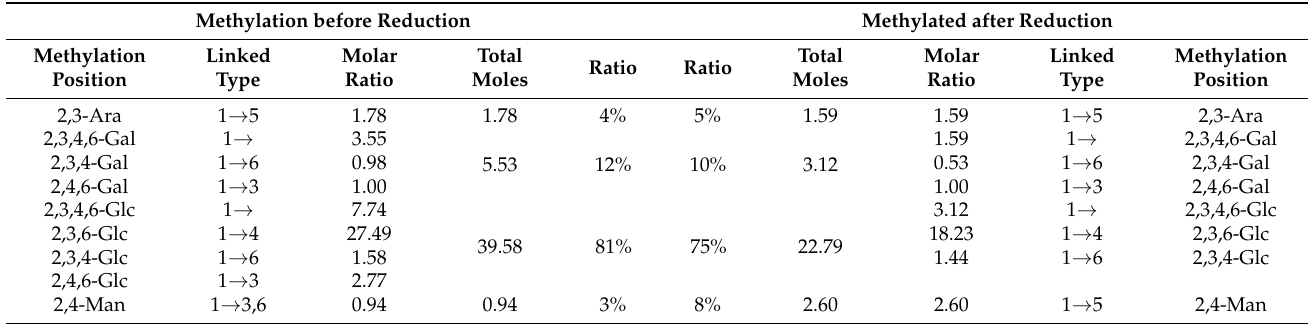
Table 2. GC–MS results of methylation before and after uronic acid reduction of